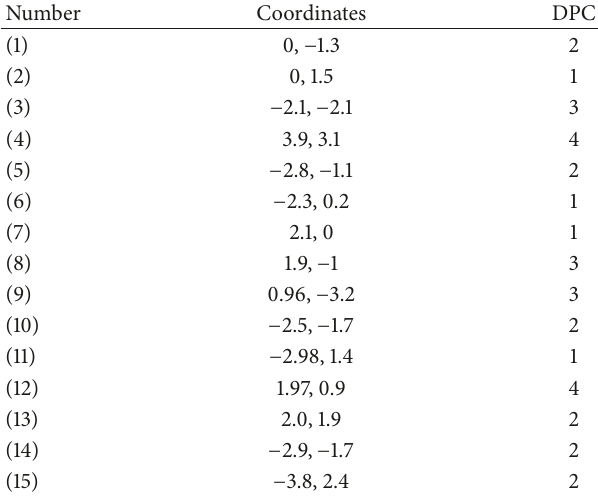
Table 1: Coordinates of customer points and demand for passenger capacity